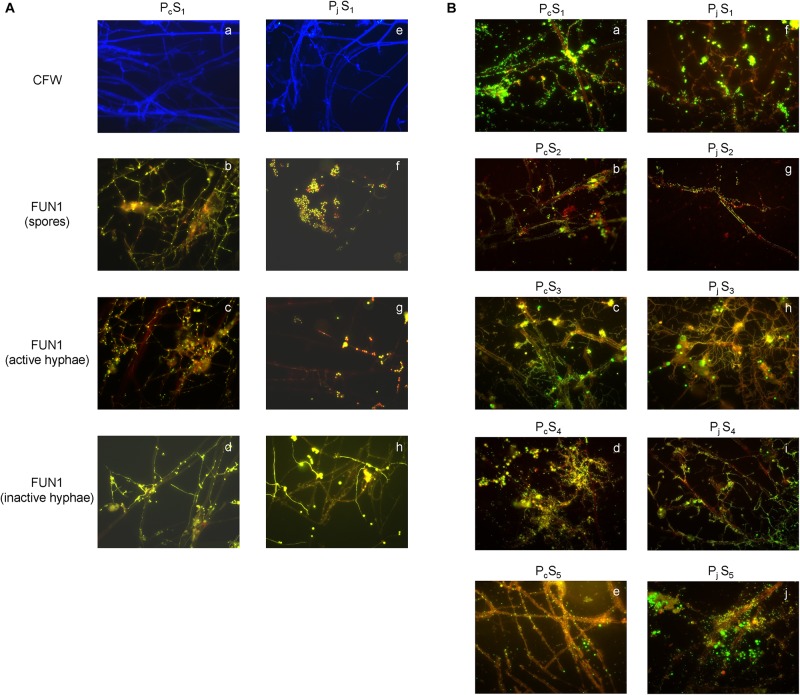
Microscopic validation for hyphal viability and bacterial colonization. (A) The structure and viability of hyphae from P. canescens (Pc) and P. janthinellum (Pj) located on the surfaces of glass cover slips after 8 days’ incubation in S1 microcosms. (a,e) Calcofluor White (CFW)-stained hyphae for Pc and Pj; (b,f) mixture of both metabolically active and inactive spores for Pc and Pj; (c,g) FUN 1-stained metabolically active hyphae with red-orange intravacuolar structures for Pc and Pj; (d,h) FUN 1-stained metabolically inactive/dead hyphae with diffuse green staining for Pc and Pj. (B) SYBR Green stained bacterial colonization on P. canescens
(a–e) and P. janthinellum hyphae (f–j) in five different soil microcosms (S1–S5). Both Pc and Pj hyphae were densely colonized by bacteria after 8 days’ incubation. All images were observed using a 63 × oil objective lens (Carl Zeiss, total magnification was 630x).